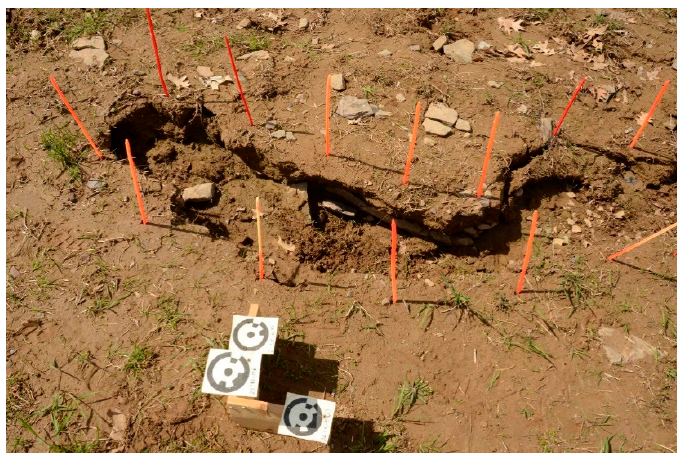
Figure 2. A portion of the water-induced channel on the soil surface. The red sticks along the side of the channel denote the locations for the cross-sections.